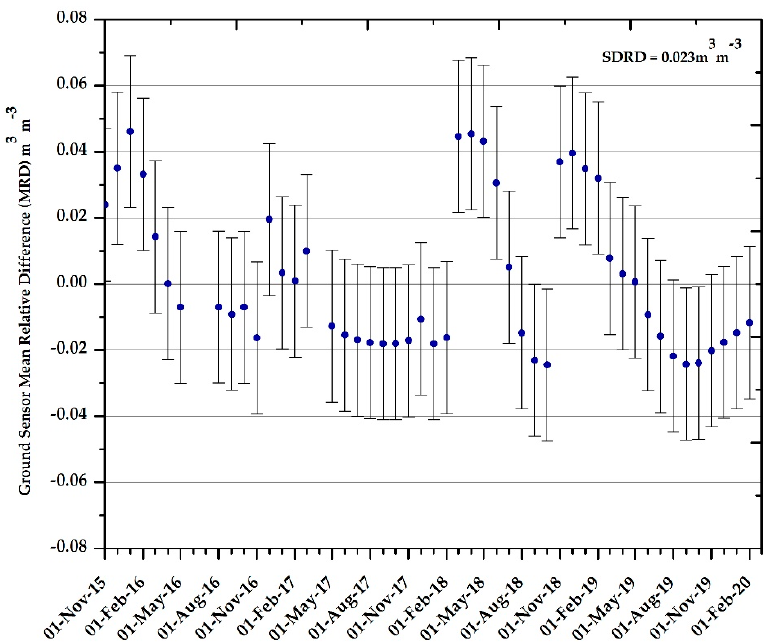
Figure 6. Mean relative difference in ground sensor